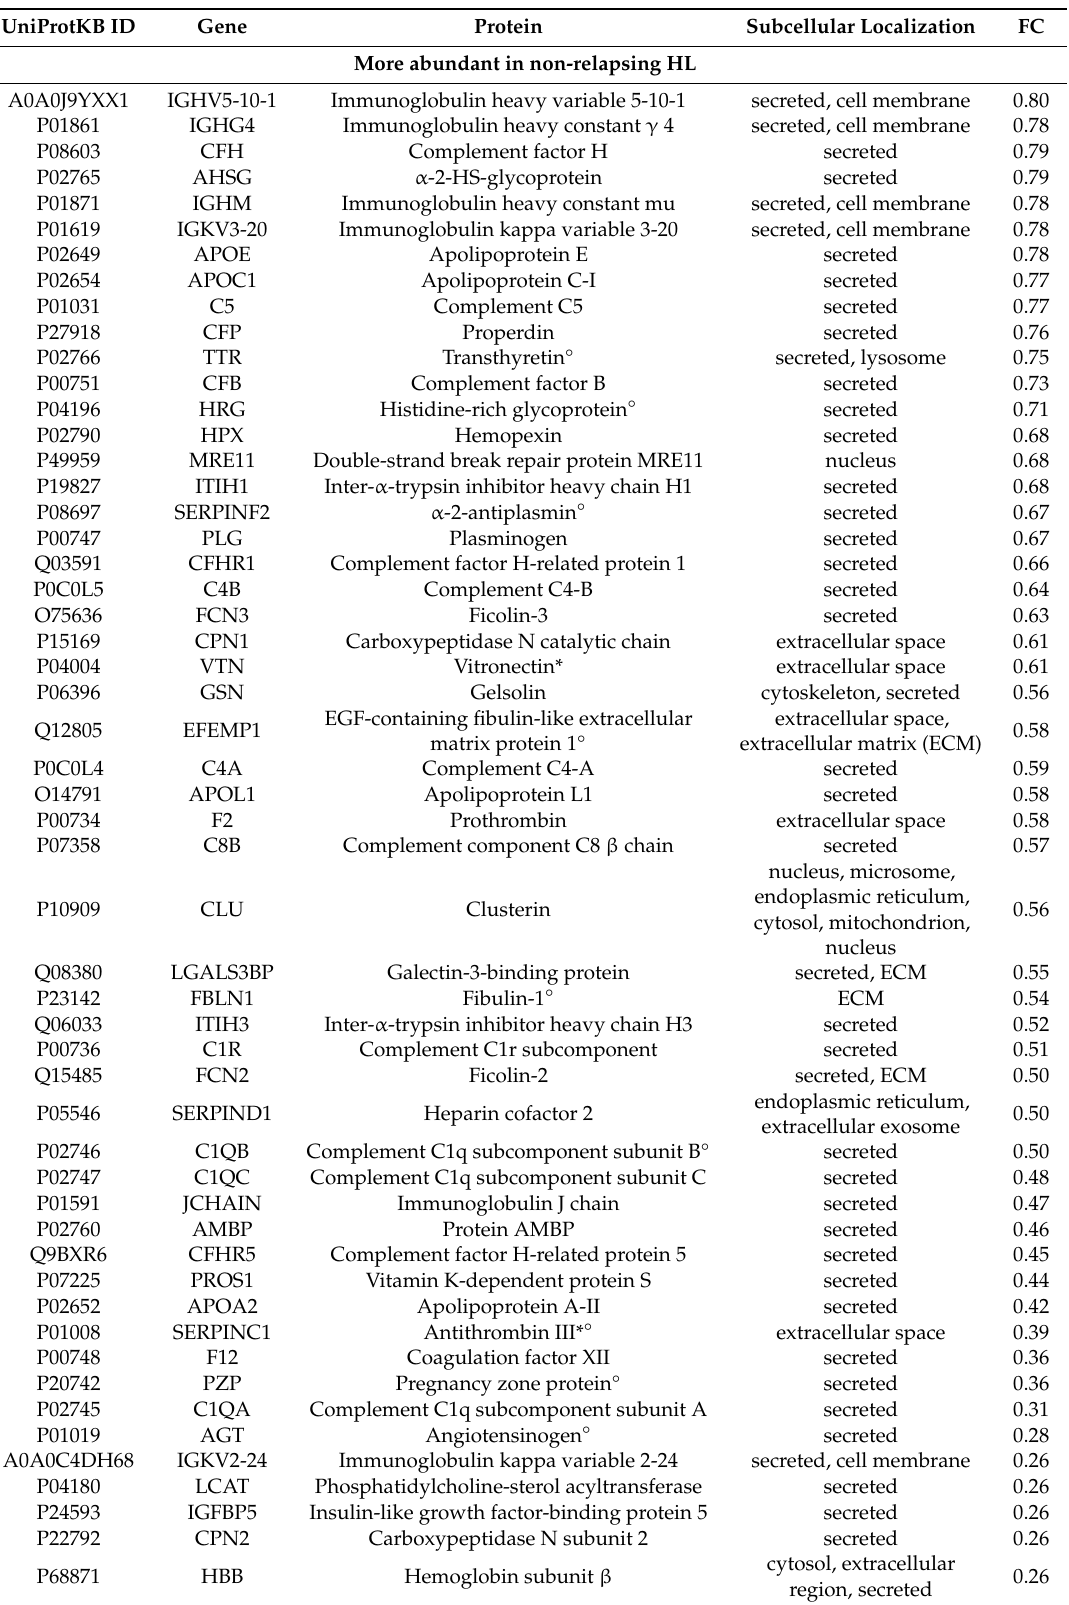
Table 2. Di ff erentially abundant proteins in plasma between patients with non-relapsing HL and relapsing pediatric HL, in the explorative